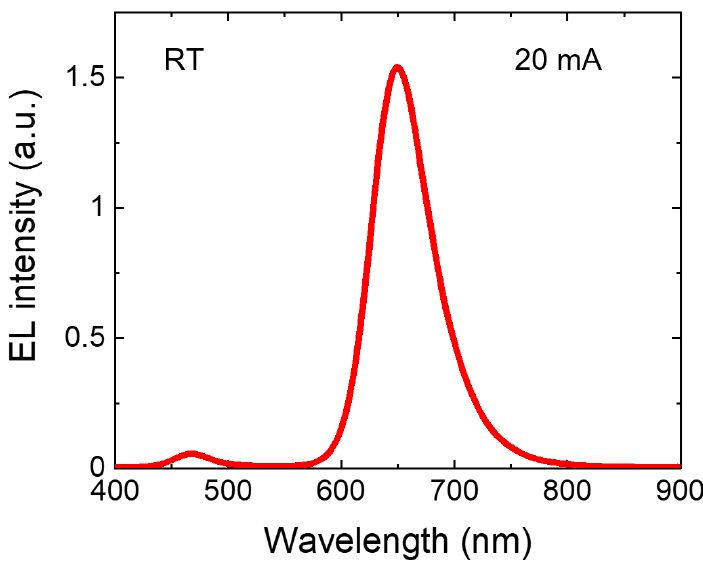
Figure 2. Electroluminescence (EL) spectrum of the red LED at 20 mA.